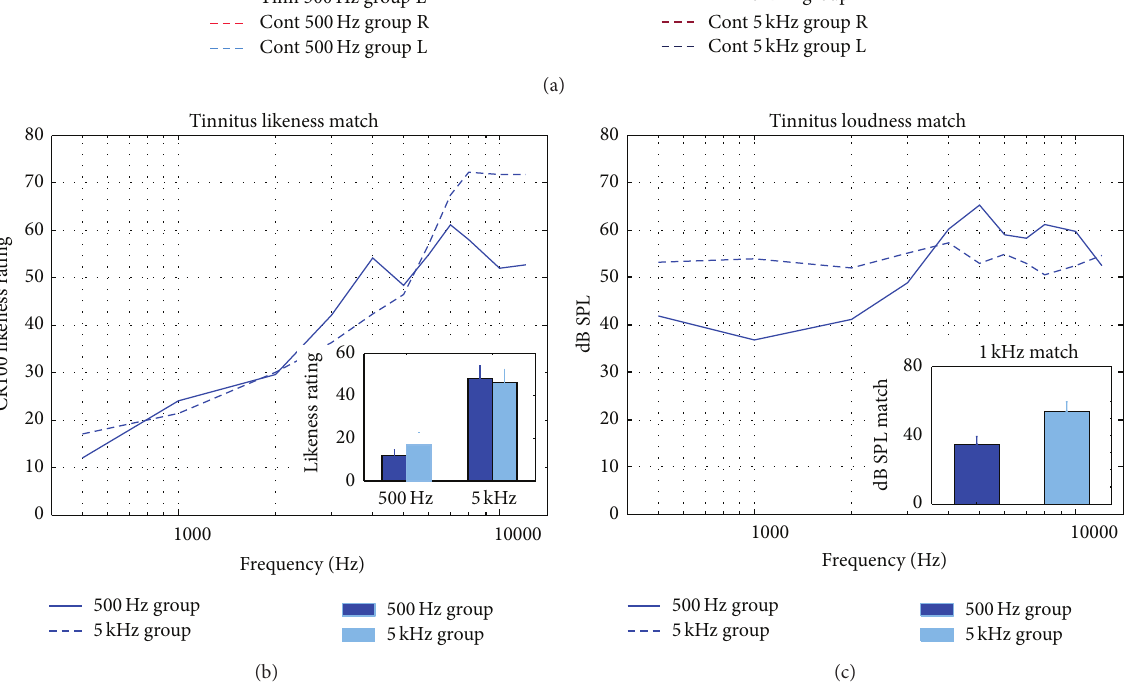
Figure 1: Audiogram, tinnitus spectrum, and tinnitus loudness matches. (a) Pure-tone audiograms (pulsed-tone method) from 0.125 to 16kHz showing each ear and group separately. Comparisons of thresholds averaged across ears at 500Hz and 5 kHz are shown in the inset bar graph (5 kHz interpolated between 4 kHz and 6kHz) separately for groups probed with 500 Hz and 5 kHz sounds. (b) Tinnitus likeness ratings from 0.5 to 12 kHz for both tinnitus groups and an inset bar graph comparing 500 Hz ratings to 5kHz ratings in each group. 500Hz ratings are below the tinnitus spectrum which commences above a likeness rating of 40 (a sound beginning to resemble tinnitus; Roberts et al. 2008). (c) Tinnitus loudness matches from 0.5 to 12 kHz for both tinnitus groups. Inset bar graphs compare loudness matches at a common 1kHz